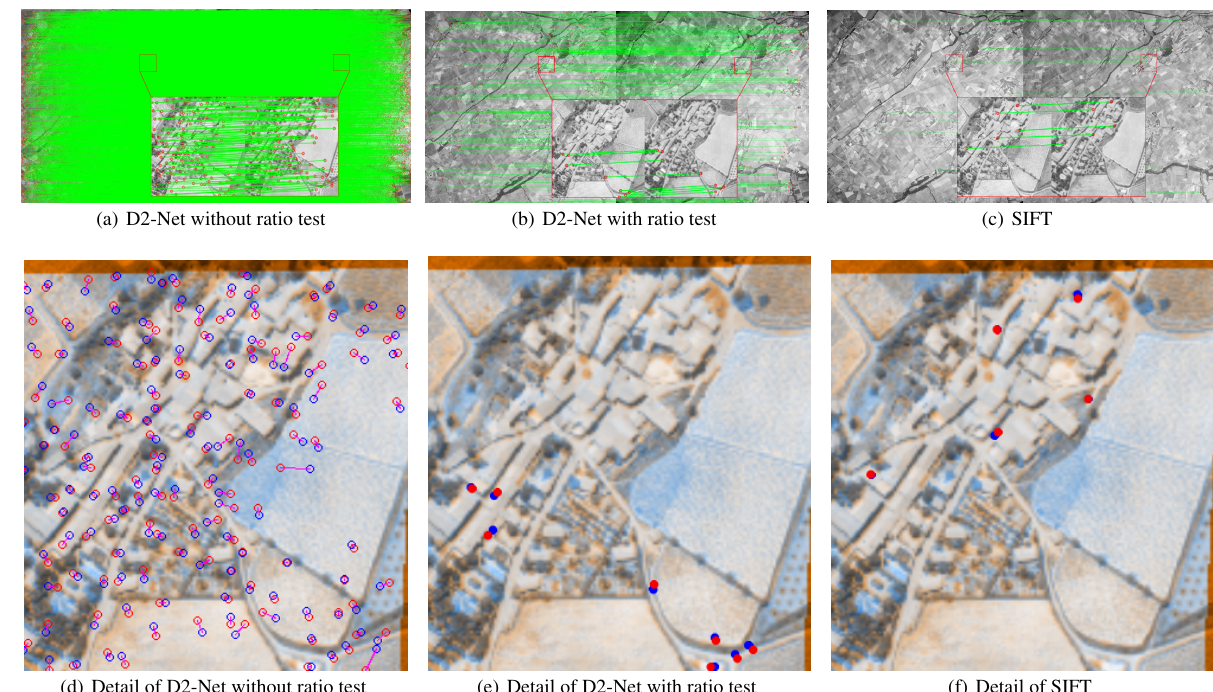
Figure 3. Matching result on inter-epoch image pair without scale change and rotation. Top: a global view, bottom: zoom over an area with the images transformed to a common geometry. Notice the offsets between the D2-Net corresponding points.